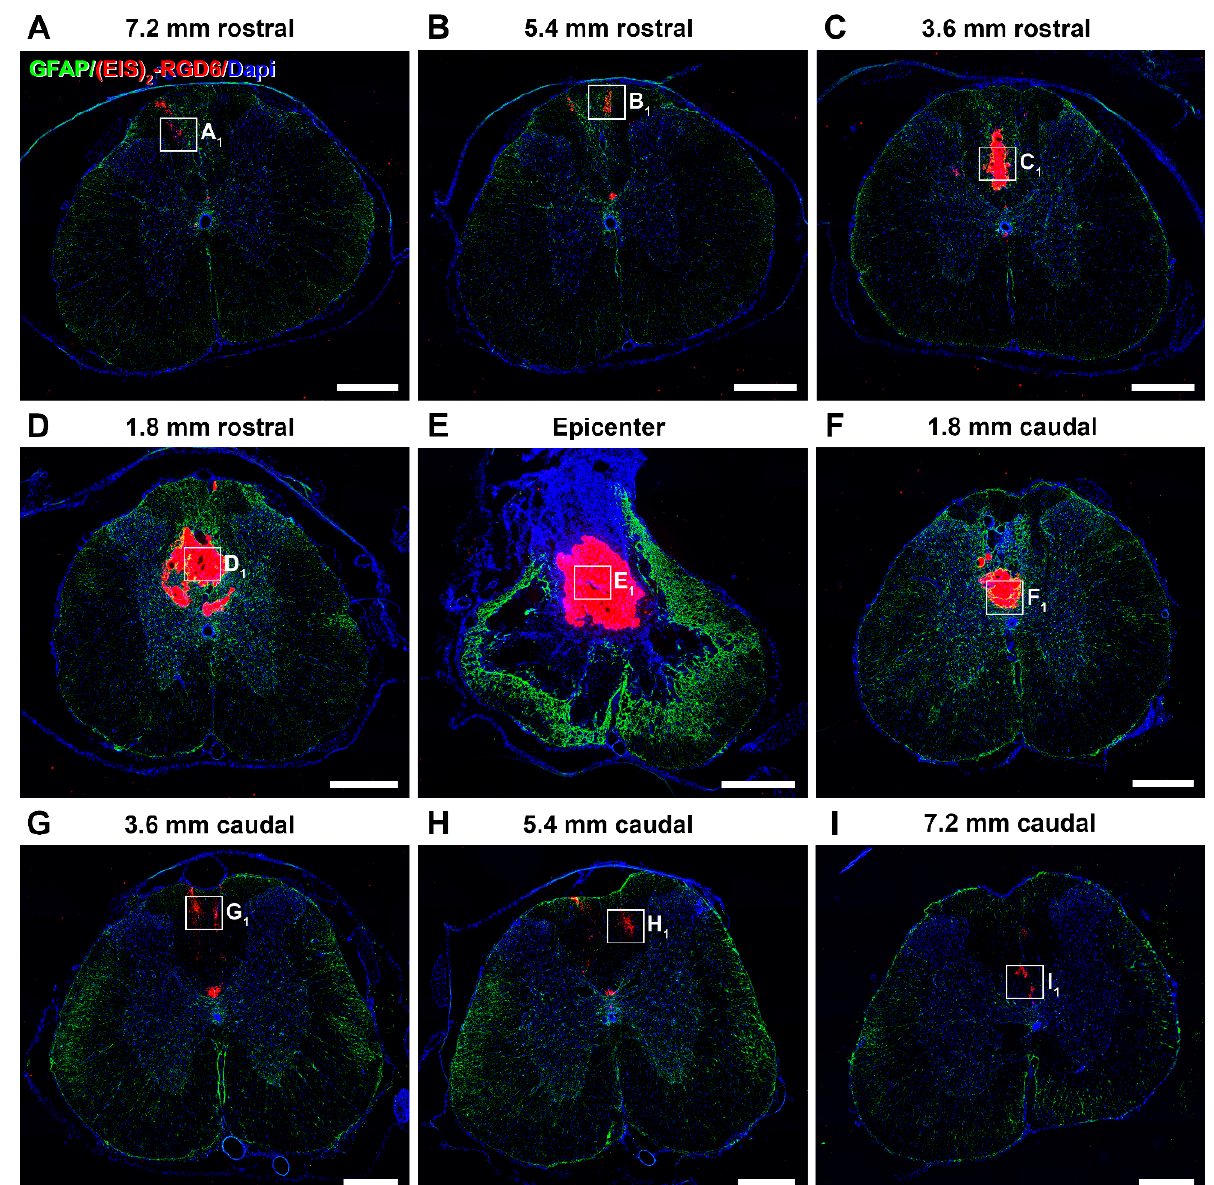
Figure 10. Qualitative microscopic analysis of (EIS) 2 -RGD6 distribution at 42 days post-injury. Representative images from whole spinal cord sections processed for the visualization of biotinylated (EIS) 2 -RGD6 and glial fibrillary acidic protein (GFAP) at 42 days post-injury [experiment (EIS) 2 - RGD6 II]. The following rostro-caudal spinal cord levels are shown: ( A ) 7.2 mm rostral; ( B ) 5.4 mm rostral; ( C ) 3.6 mm rostral; ( D ) 1.8 mm rostral; ( E ) 0 mm; ( F ) 1.8 mm caudal; ( G ) 3.6 mm caudal; ( H ) 5.4 mm caudal; and ( I ) 7.2 mm caudal from epicentre. Scale bars, 500 µm. Please note that higher magnification images corresponding to the areas highlighted with squares in ( A – I ) can be found in Figure 12.